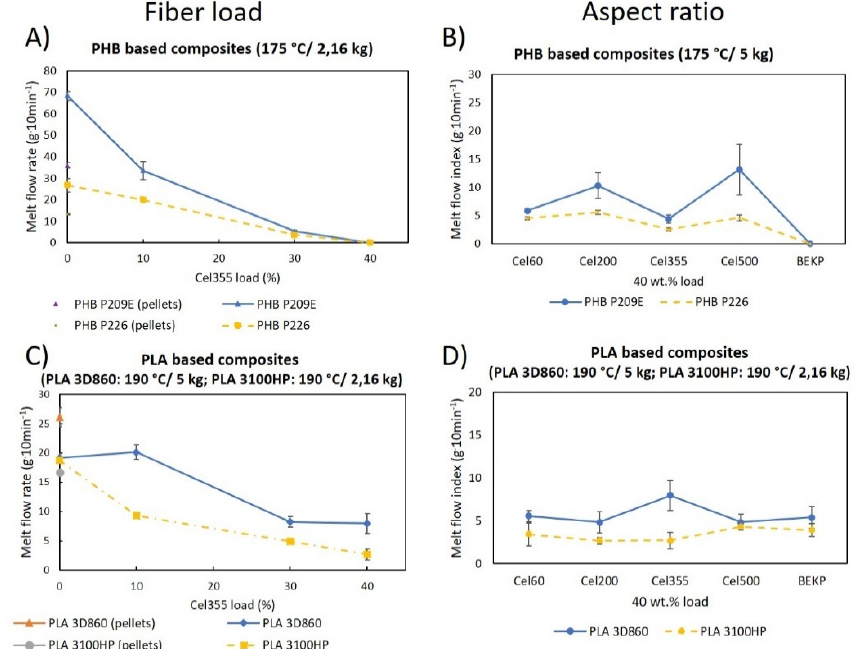
Figure 10. MFR of the polymeric matrices before and after melt-mixing: ( A , C ) their composites with Cel355 and ( B , D ) of the composites with fibers having different aspect ratios.